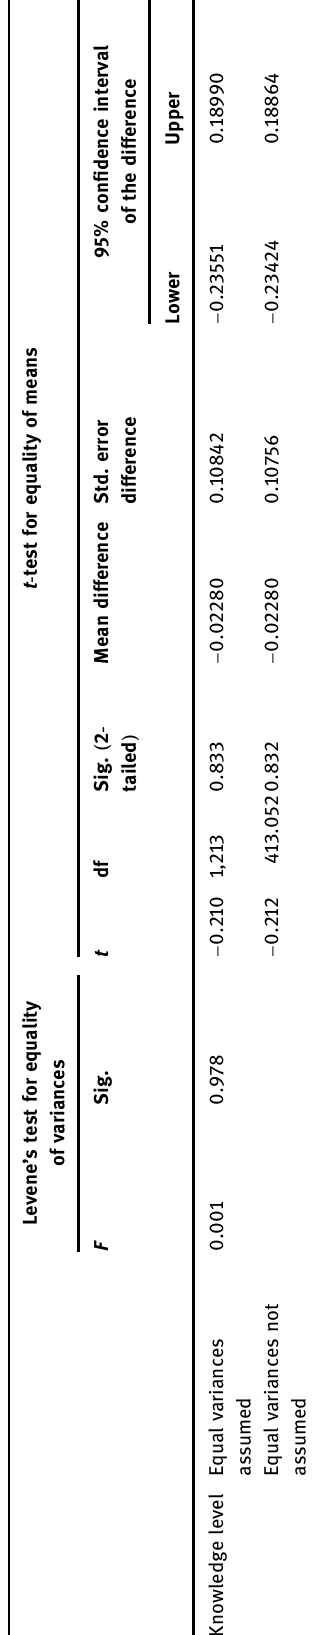
Table 11: Group statistics of knowledge level by public school and